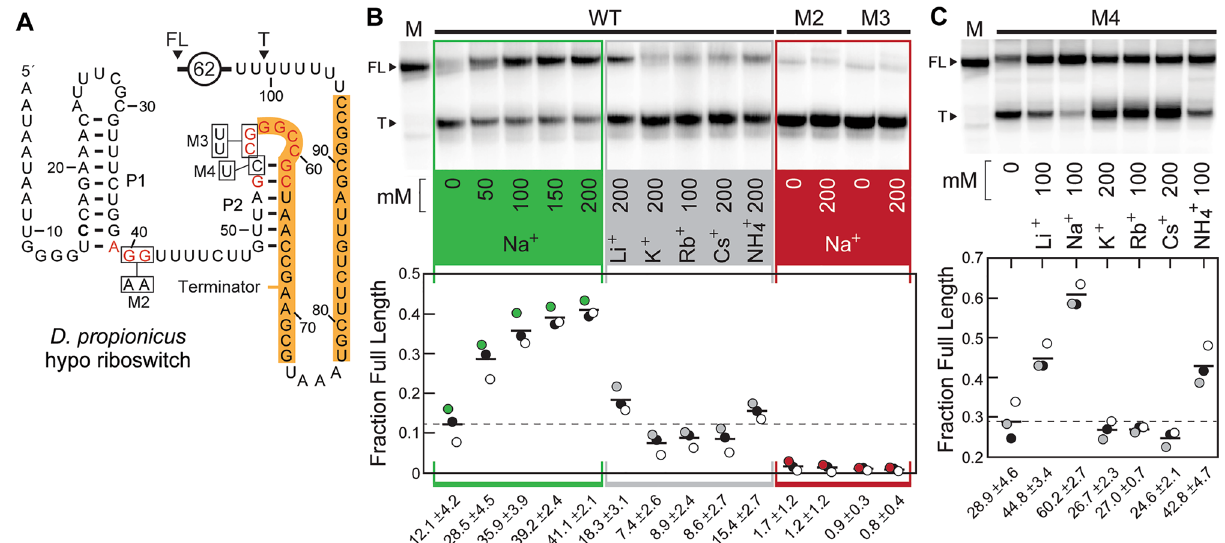
Figure 5. Variants of Li + -I riboswitches naturally respond to Na + . ( A ) Sequence and secondary structure model for a Na + -sensing riboswitch associated with a gene annotated as “hypothetical” (Supplementary Table I in the Supplement) from D. propionicus . Orange shading indicates alternative pairing that is predicted to form an intrinsic terminator stem. Predicted terminated (T) and full-length (FL) RNA transcripts are denoted with arrowheads. Other annotations are as described for Figs. 2 and 3. ( B ) Top: PAGE autoradiogram of an example single-round transcription termination assay series with a DNA template producing the D. propionicus construct depicted in A. Bands corresponding to FL and T transcripts identified in A are denoted. Transcription reactions were supplemented with the ions as indicated, and M identifies the lane loaded with a marker approximating FL RNA. Bottom: plot of the fraction of FL transcripts for each transcription reaction conducted in triplicate, where the circle colors matching the panels were derived from the gel shown. The dashed line represents the average fraction FL in the absence of additional ion supplementation above the 4 mM Na + initially present in the transcription reaction. An uncropped version of the gel image is presented as Supplementary Fig. VIII in the Supplement. ( C ) Top: PAGE autoradiogram of an example transcription termination assay series using RNA construct M4, which carries a C54U mutation that represents the nucleotide at this position most commonly observed with nhaA -I motif RNAs. Bottom: Plot of the fraction of FL transcripts for each transcription reaction conducted in triplicate (n = 3), where the numbers indicate the mean and standard deviation. Additional annotations are as described for B. An uncropped version of the gel image is presented as Supplementary Fig. IX in the